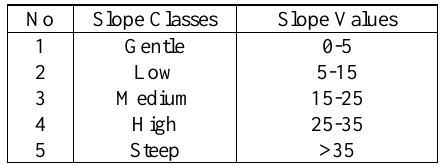
Table 5. Ground slope (%) classes